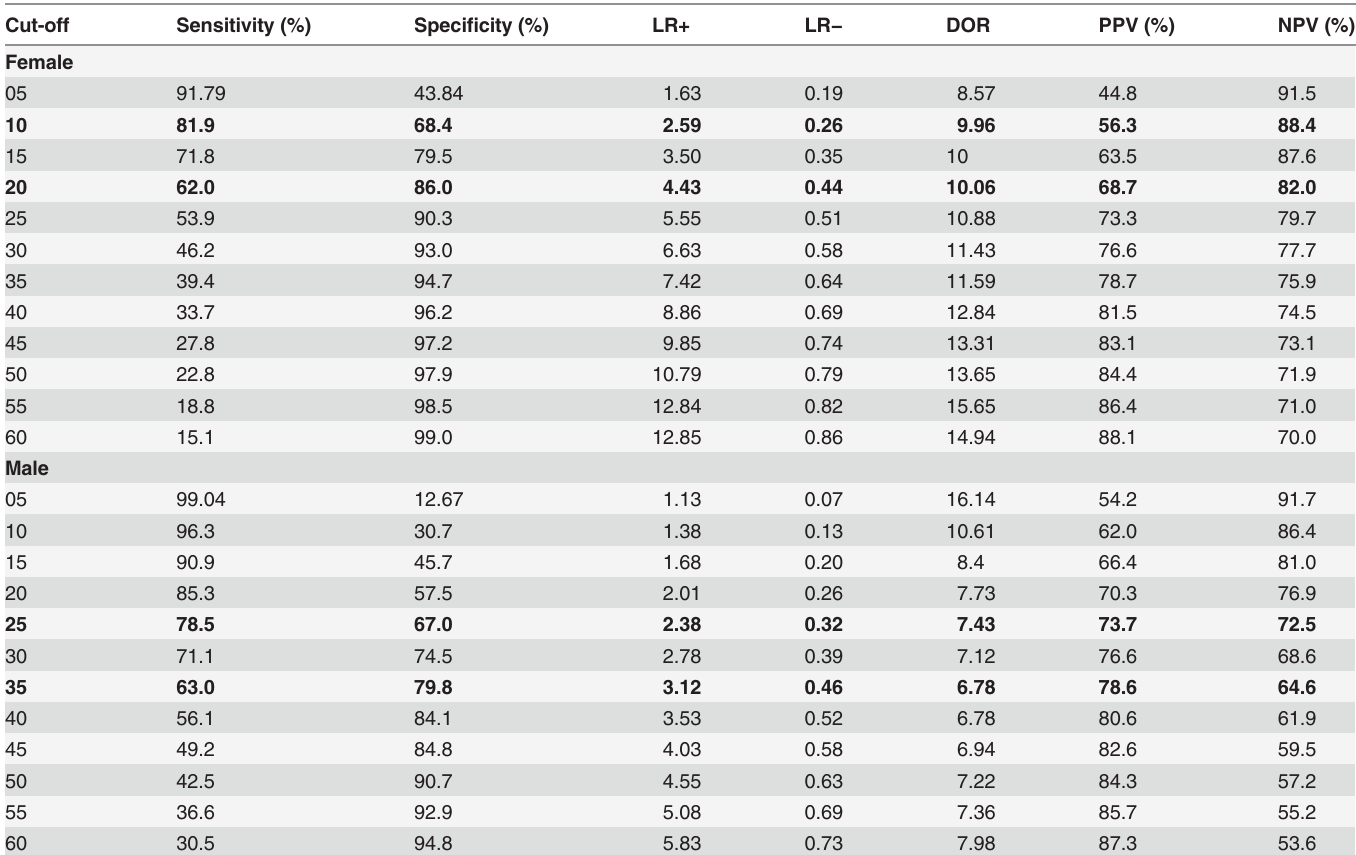
Table 4. Selecting the optimal cut-off value of FLI in identifying ultrasonogrphic fatty liver stratified by gender.